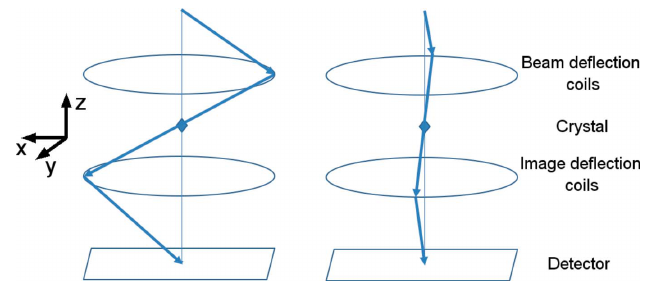
Figure 1 A schematic ray diagram of the two static electron beam experiments simulating a precession experiment (beam tilt and image tilt). The phases of the image tilt are 0 (cid:2) (tilt in the xz plane) and 90 (cid:2) (tilt in the yz